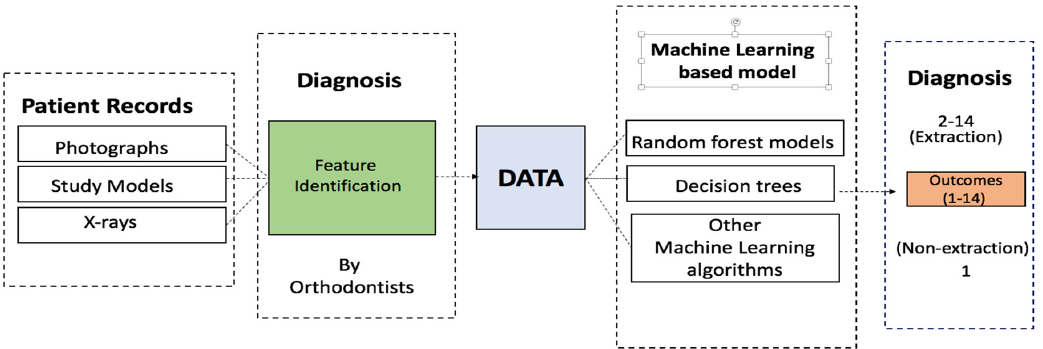
Figure 1. Schematic of the procedure followed in this work, from data collection to the machine learning